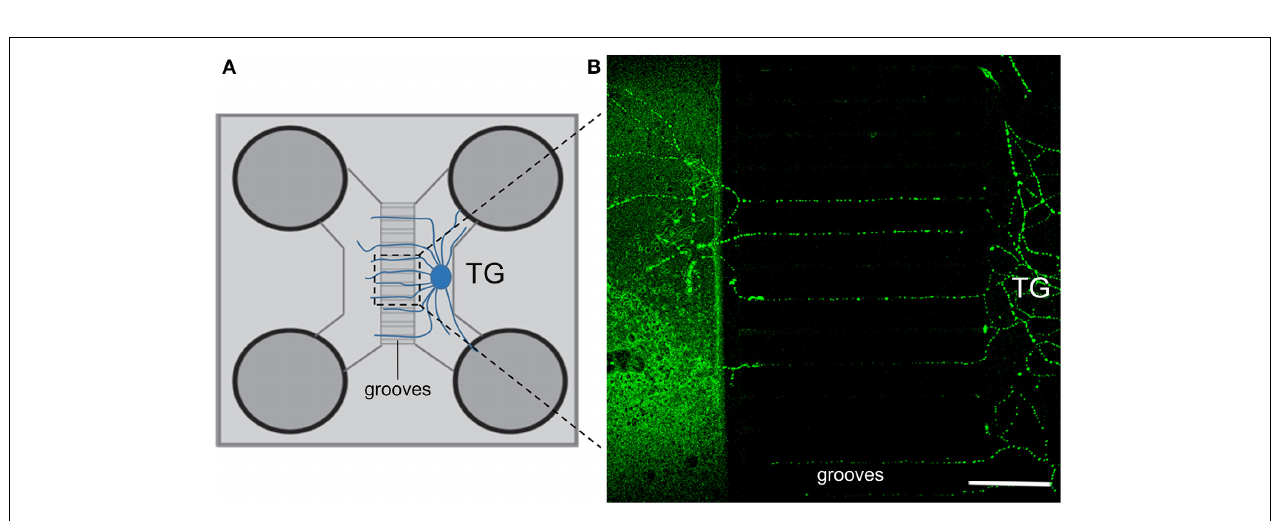
FIGURE 3 | General setup and growth of neurites through the microgrooves of the microfluidics device. (A) Schematic view of a microfluidics co-culture system device. (B) Both β -tubulin (green) and